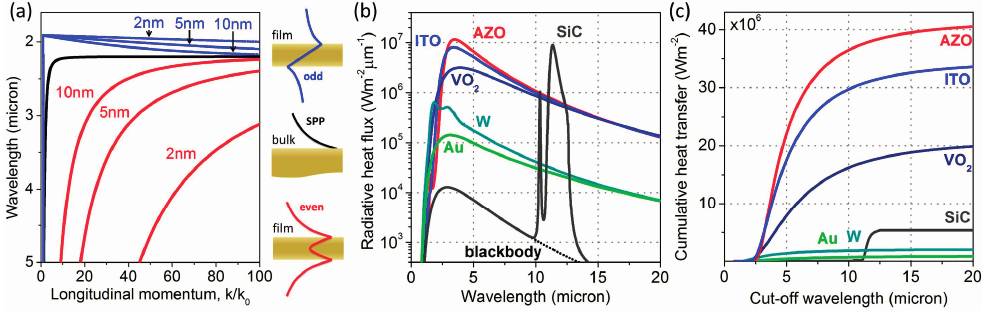
Figure 3. SPP-mediated heat transfer between ultrathin films. ( a ) The band structure of SPP modes for a single metal-air interface (black) and thin films with progressively smaller thicknesses. The red and blue branches correspond to the even and odd coupled SPP modes, respectively. Schematics of the modal field profiles are shown in the insets. The = 1.1 μ m , γ= 0 , ε = 3 . ( b ) The heat flux spectra as a Drude model parameters are λ ∞ p function of wavelength between 2 nm-thin emitters and absorbers supporting surface polaritons. The gap width is 20 nm, and the hot and cold side temperatures are 1000 K and 360 K, respectively. The blackbody heat flux is shown as the dotted line for comparison. λ ( c ) Cumulative heat flux per unit area in the spectral range below a cut-off wavelength c between the same materials as in ( b